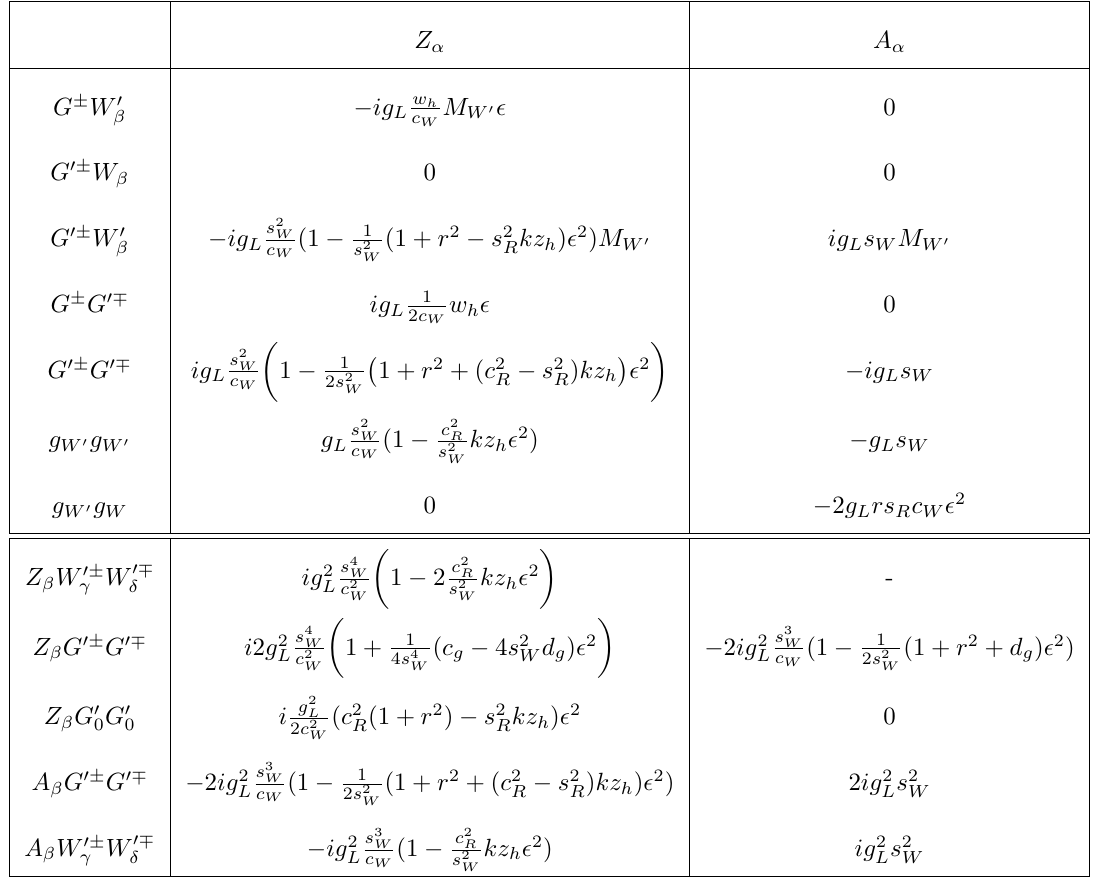
)(1 + r 2 ), d g = ( c 2 (cid:0) s 2 ) kz h and M W 0 is the mass of the W 0 W R R